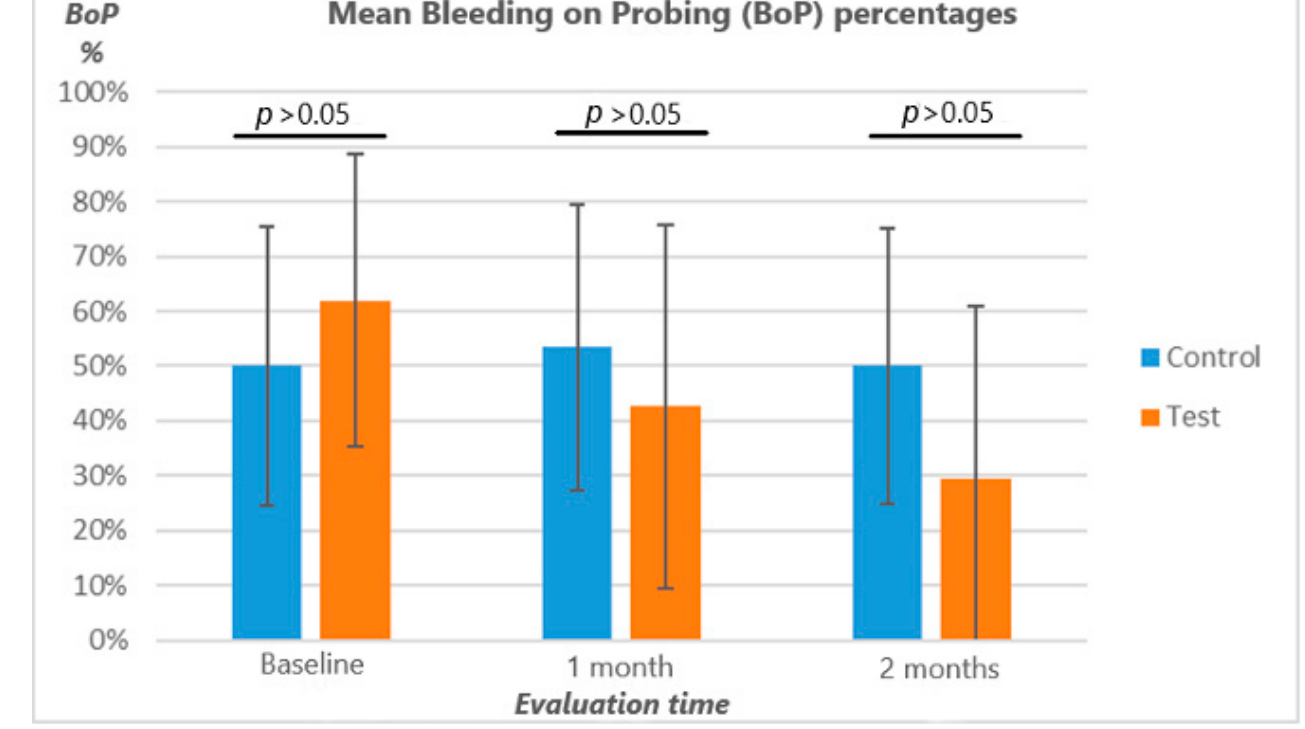
Figure 4. Bleeding on Probing percentages (%): the figure shows the absence of intergroup differences at all the evaluation times ( p > 0.05). As to intragroup differences, a progressive significant reduction in the index was assessed in the trial group but not in the control one.